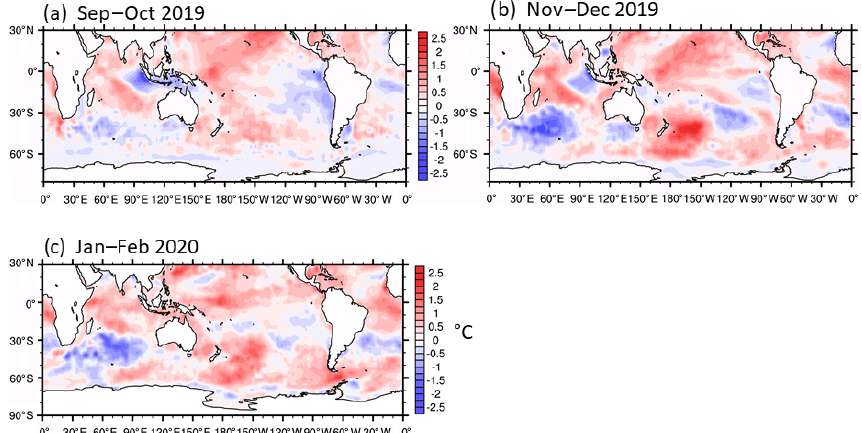
Figure A5. Sea surface temperature (SST) anomalies relative to 1982–2019 mean for (a) September and October 2019, (b) November and December 2019, and (c) January and February 2020. SST data are NOAA OI